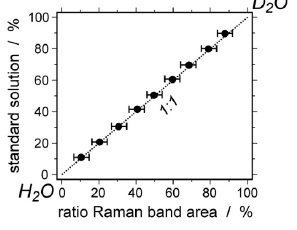
Figure 6. Comparison between standard solutions of H 2 O-D 2 O mixtures with known composition and area fractions in Raman spectra. Equation (1) is represented by the diagonal dashed line (1:1). Comparison of this D 2 O composition with corresponding melting temperatures T m (SV → LV) of